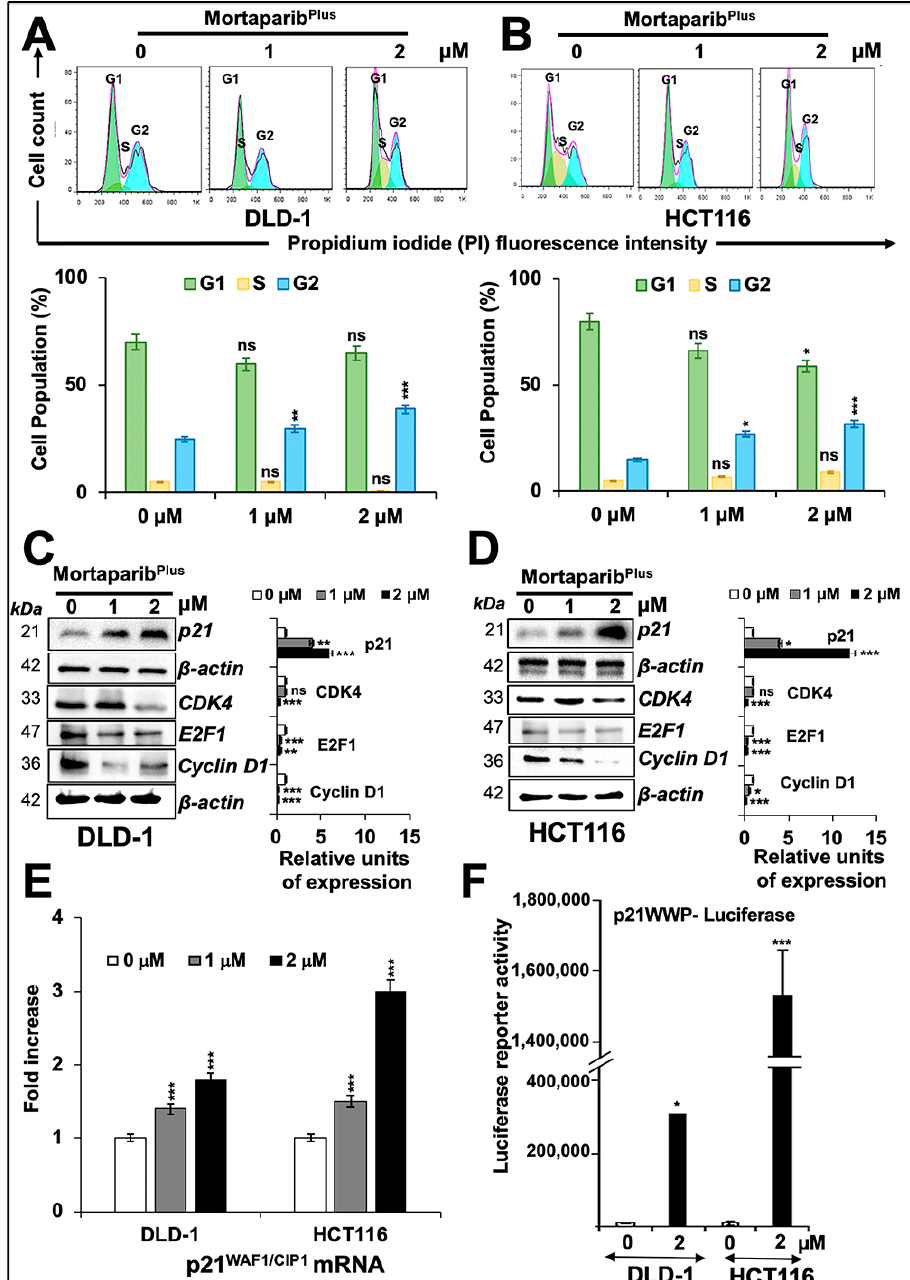
Figure 5. Mortaparib Plus -treated colorectal cancer cells underwent G 2 /M cell-cycle arrest. Flow cytometric analyses for control and Mortaprib Plus -treated cells showed an increase in the percentage of cell populations in the G 2 phase of cell cycle ( A , B ). Western-blot analyses of control and 24 h Mortaparib Plus -treated cells showed an increase in p21 WAF1 protein levels and a decline in CDK4, E2F1 and Cyclin D1 proteins ( C , D ). Note that the loading control ( β -actin) for panel C and D (CDK4, E2F1 and Cyclin D1) is the same as the one used for Caspase-7 shown in Figure 4C and D , respectively. RT-qPCR analyses showed a dose-dependent increase in the p21 WAF1 gene expression in 24 h Mortaparib Plus -treated cells ( E ). Luciferase reporter assays using pWWP-Luc containing p21 WAF1 promoter showed a strong increase in the luciferase activity in the 24 h Mortaparib Plus -treated HCT116 (p53 WT ) cells and a moderate increase in Mortaparib Plus -treated DLD1 (p53 S241F ) cells after the same incubation time ( F ). The quantified data represents mean ± SD obtained from three independent biological replicates; p -values were calculated using unpaired Student’s t -test. * < 0.05, ** < 0.01, and *** < 0.001 represent significant, very significant and very very significant,